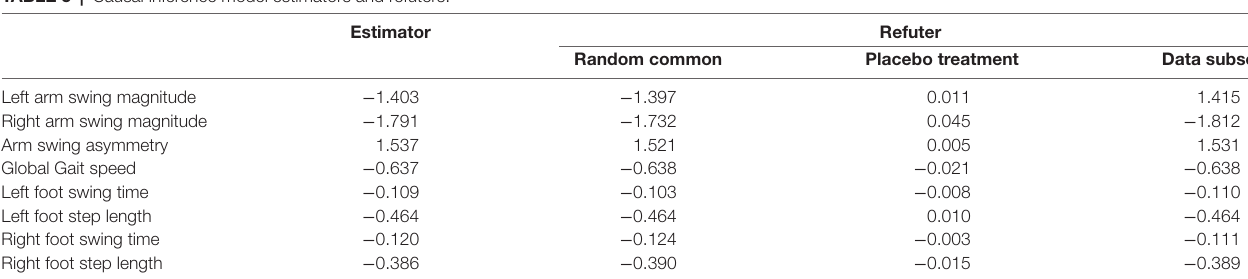
TABLE 5 | Causal inference model estimators and